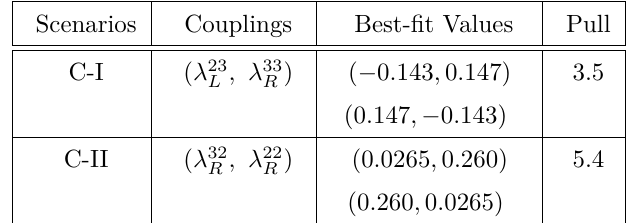
Table 6 . . Best-fit values of new LQ couplings, and pull values for all cases (C-I, C-II).